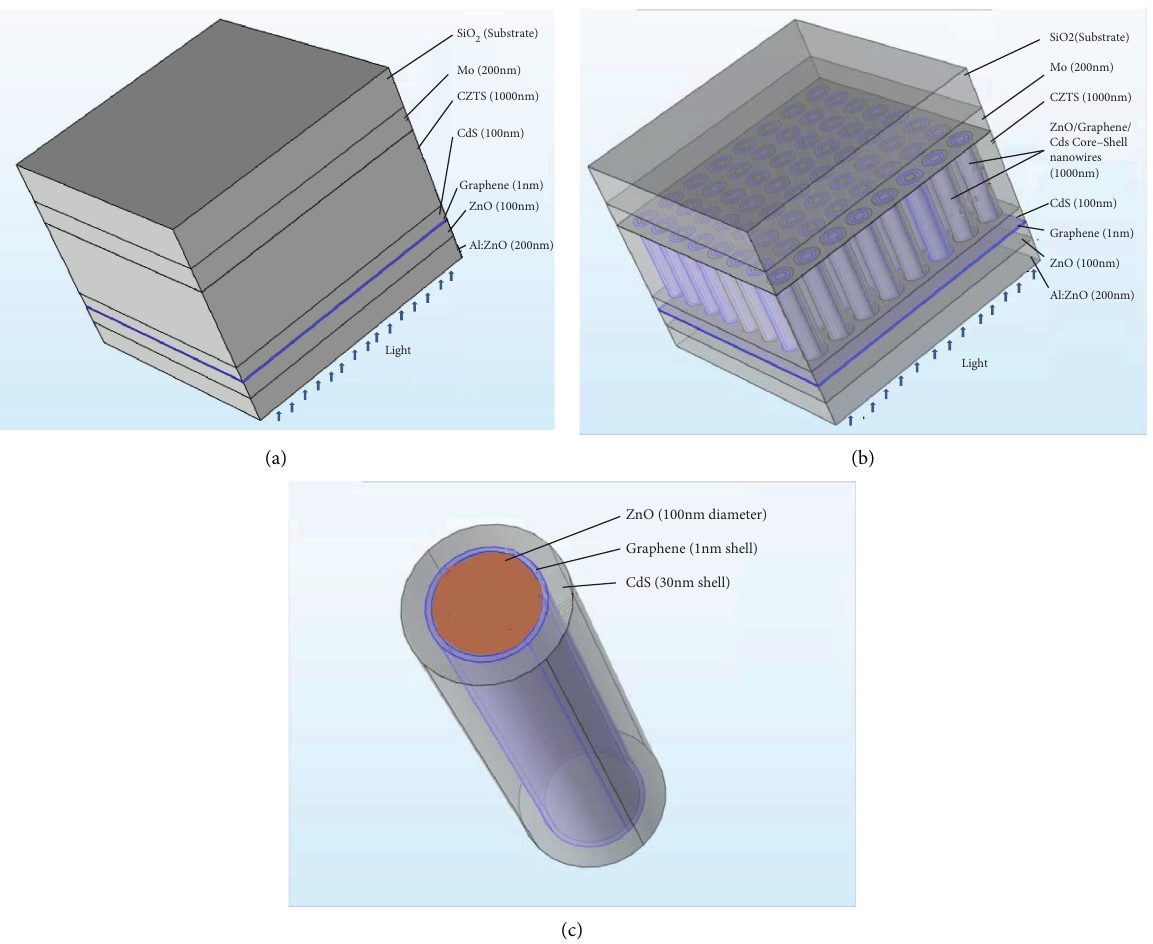
Figure 2: Optimized full model architectures of (a) thin film, (b) core-shell nanowires of CZTS solar cells, and (c) single core-shell nanowire